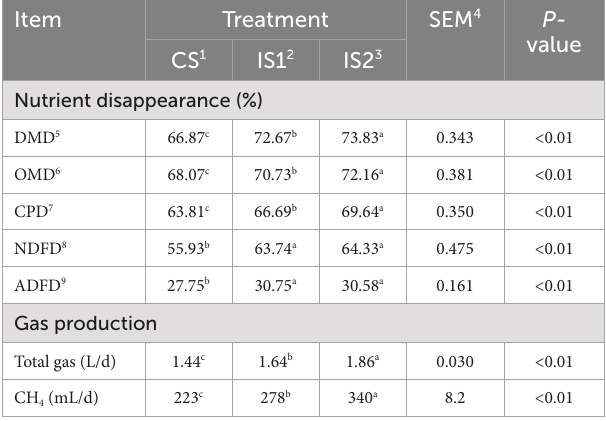
TABLE 2 Influences of different stirring times on RUSITEC fermentation characteristics.